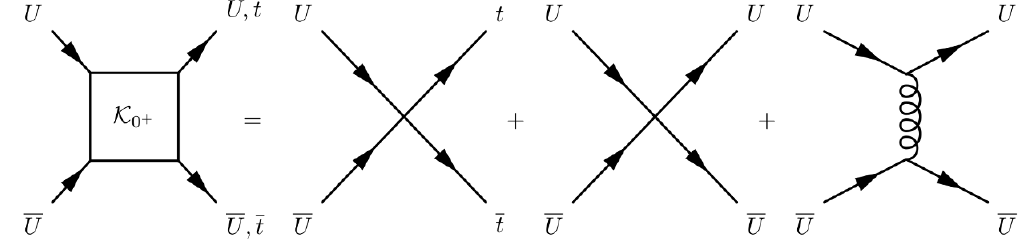
Figure 2 . The kernel for scattering of (cid:22) UU ! (cid:22) tt and (cid:22) UU ! (cid:22) UU including ETC contact terms and one-TC-gluon